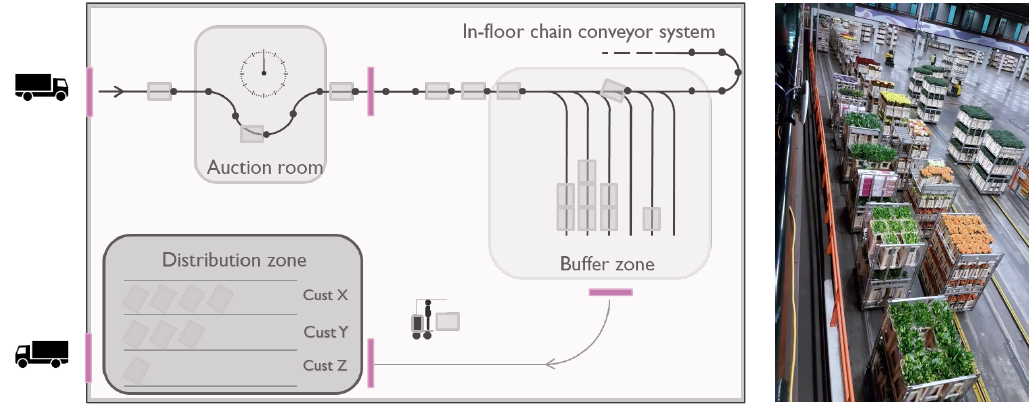
Figure 6. Sample warehouse floor plan with various